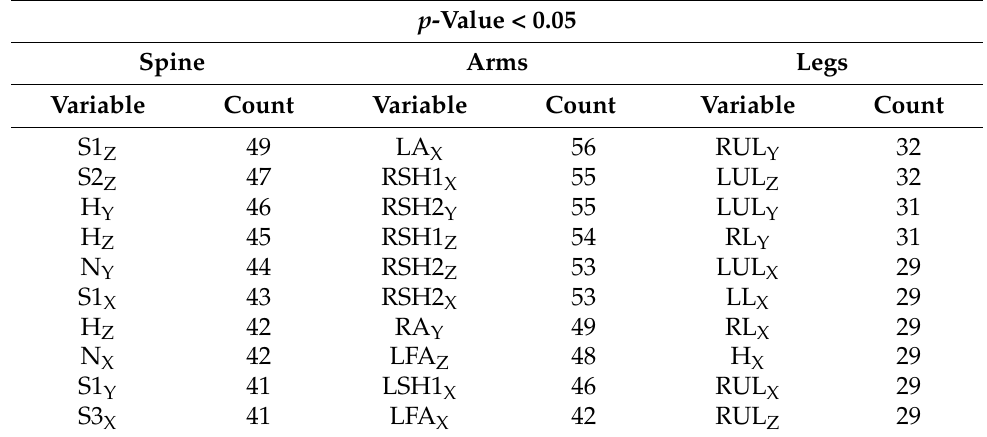
Table 1. G 1 : Televison assembly.